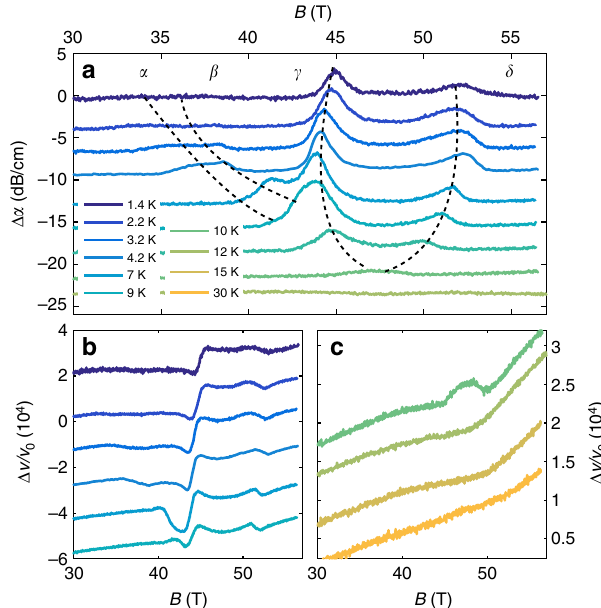
Fig. 4 Temperature dependence of the elastic properties of graphite. a Attenuation as a function of B for f = 255 MHz and temperature ranging from 1.4 to 12 K. The dashed lines are eye-guiding to illustrate the temperature dependence of the α , β , γ , and δ -transitions. The temperature dependence of Δ v v is shown in b , c from 1.4 to 9 K and from 10 to 20 K, 0 respectively. Full data set is reported in Supplementary Fig